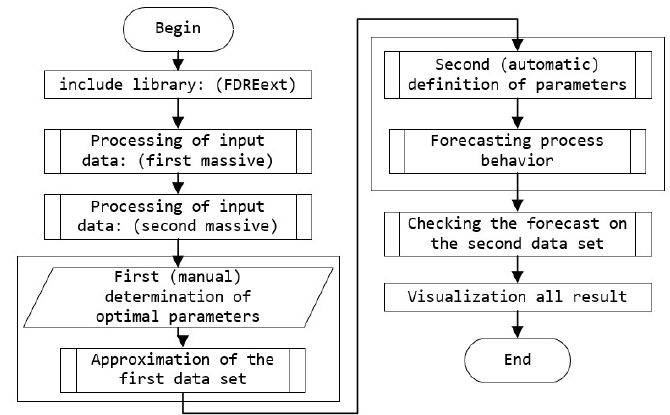
Figure 1. Generalized block diagram of the software package.